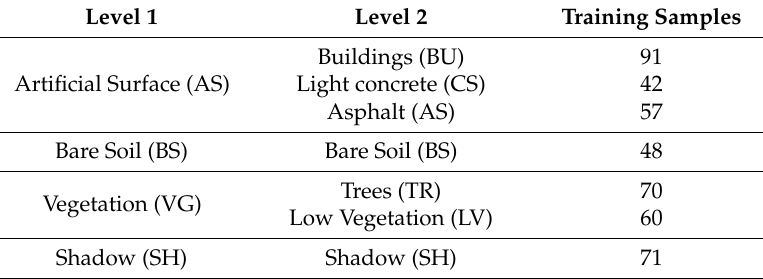
Table 2. Classification scheme and training data for each